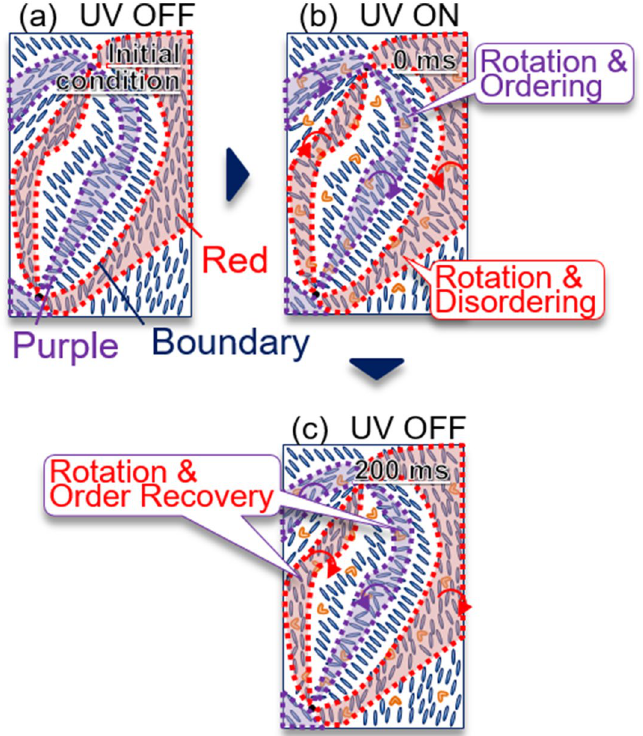
Figure 6. The schematic drawings of the molecular alignment change (a) before the light irradiation (− 20 ms), (b) during the irradiation (0, 190 ms), and (c) after irradiation (200 ms ~), The purple and red regions correspond to each colored brush (prepared by PowerPoint